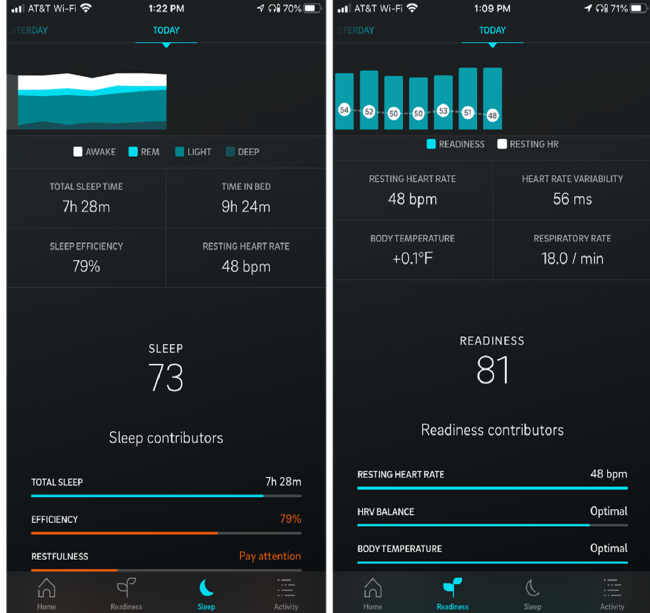
Figure 4. Sleep/Sleep Physiology Data. Figure 4. Sleep / Sleep Physiology